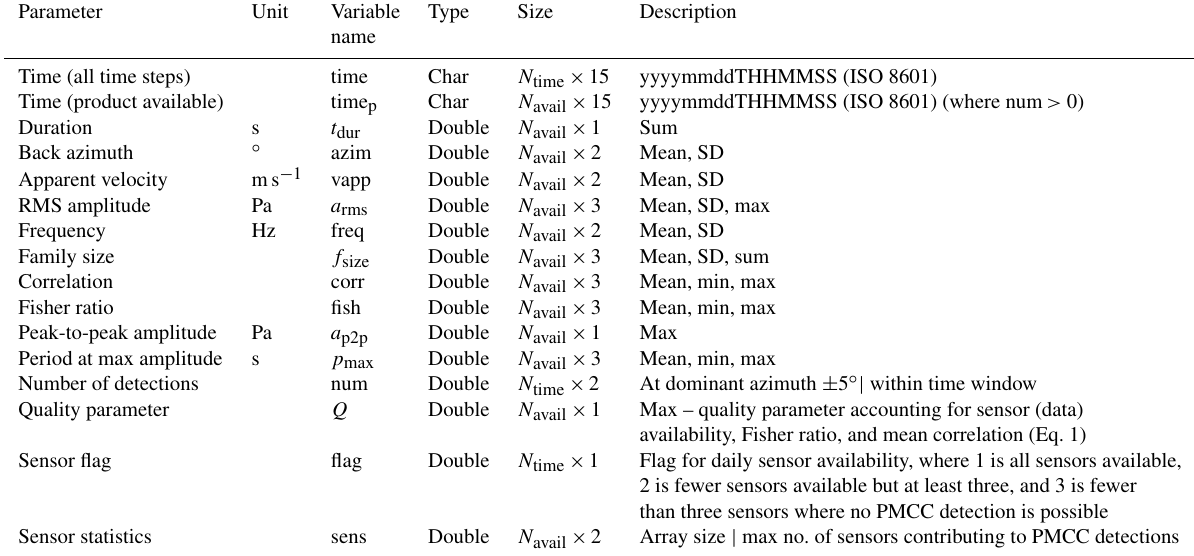
Table 1. Overview of the data product parameters provided in the netCDF files for each station. All mean, min, max, and sum values correspond to all detections within the dominant azimuth ± 5 ◦ . The mean values are weighted by family size of the detections. The standard deviation (SD) accounts for all detections within the considered time window and refers to the calculated mean. N time denotes the total number of time steps, whereas N avail denotes the number of time steps with product parameters